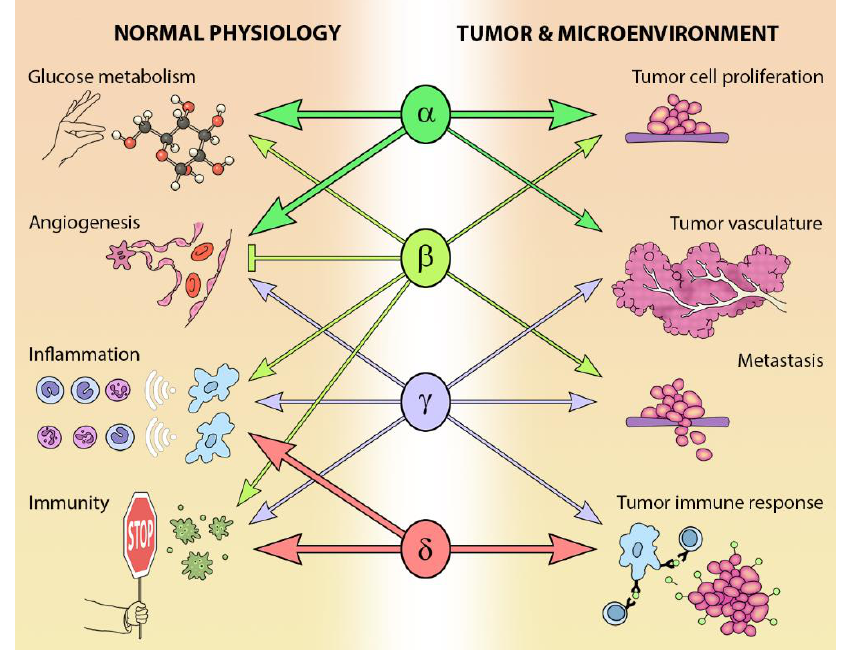
Figure 3. Isoform-specific roles of Class I PI3Ks in normal and cancer physiology.